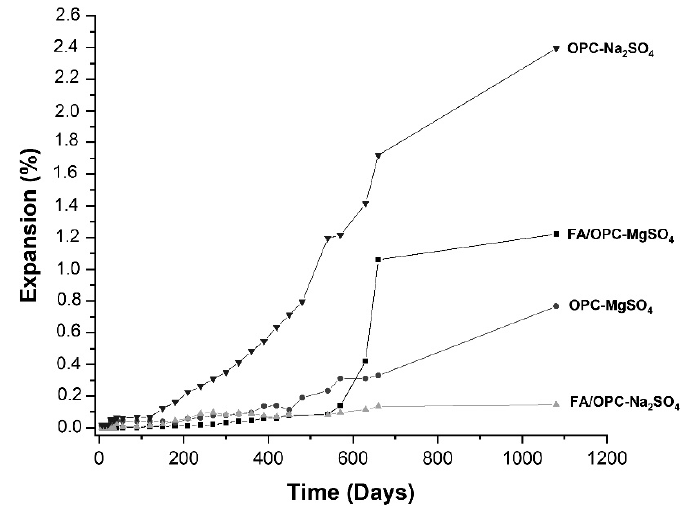
Figure 1. Expansion vs. time for the concrete exposed to Na 2 SO 4 and MgSO 4 .